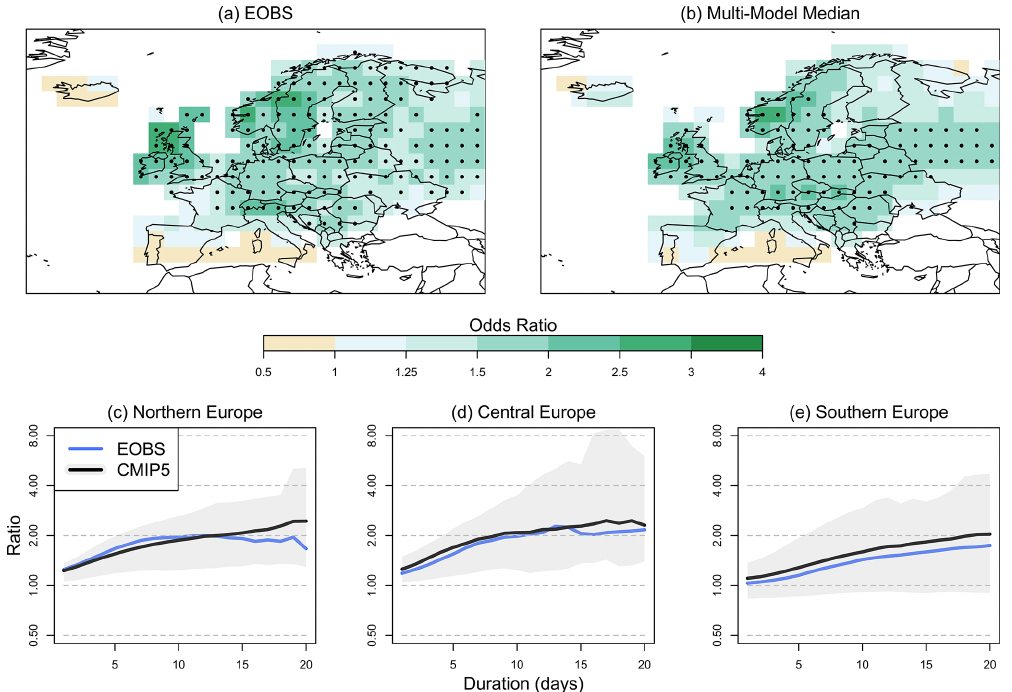
Figure 5. Comparison of the relationship between dry spells and temperature quantified as the odds ratio (OR HD ,n ) (see Sect. 3.1) in (a) EOBS and (b) the CMIP5 multi-model median. Stippling indicates that there is a less than 5% probability that the odds ratio can be achieved by random chance. Only dry spells longer than 5d are included. Sensitivity of the odds ratio to the duration of dry spells averaged across (c) northern Europe, (d) central Europe and (e) southern Europe for EOBS (blue line) and the CMIP5 multi-model median (solid black line). The grey area represents the model spread in the